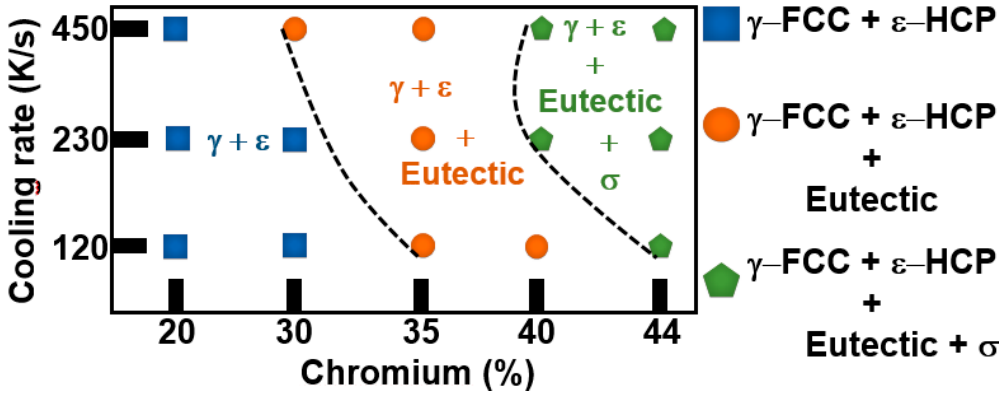
Figure 12. Mapping of the various phases found including intermetallics and the eutectic constituent as a function of cooling rates and % Cr.